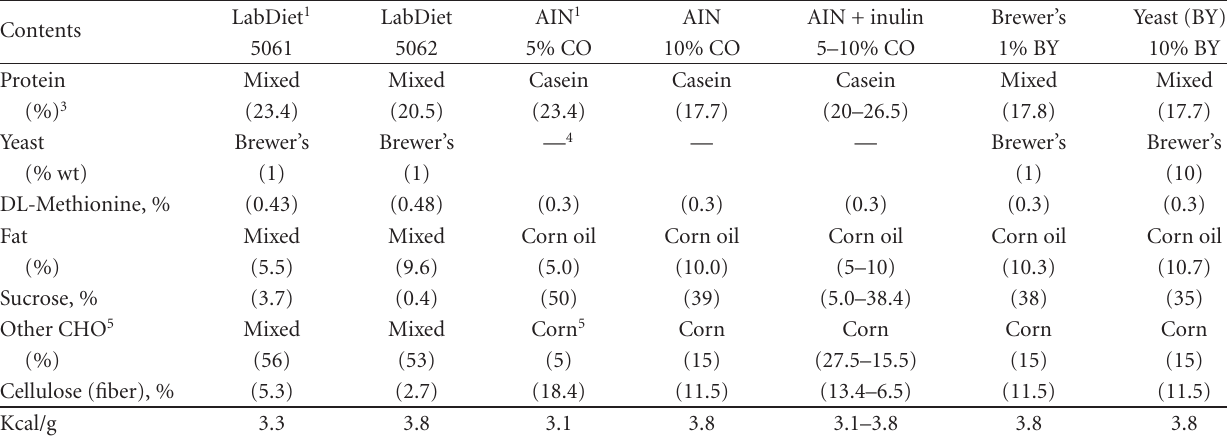
Table 1: Diet compositions.